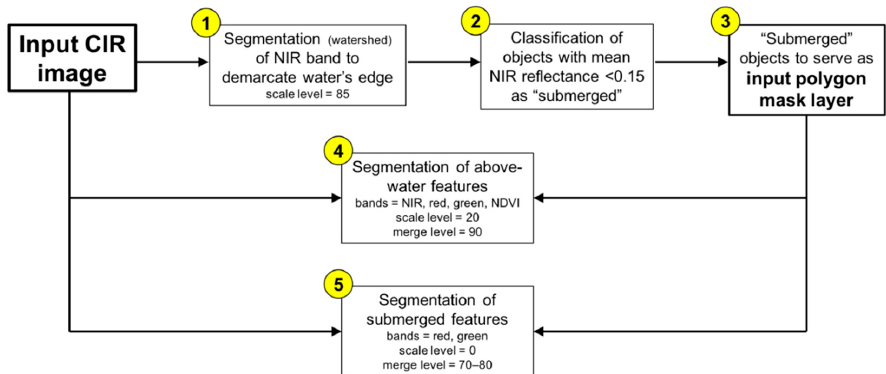
Figure 4. Flowchart of multistage image segmentation. The polygon mask layer created in step 3 is used to separately segment above ‐ water and submerged features in steps 4 and 5, respectively, which then separately undergo classification.